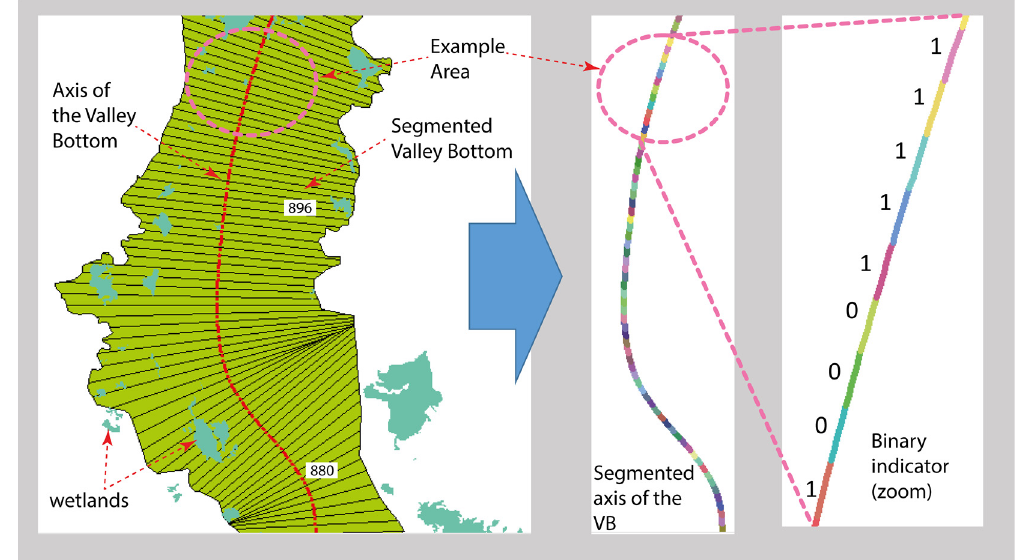
Figure 2. Creating the “river skeleton”: geomorphological units in the active channel (e.g., islands, bars, pools, riffle) or in the VB (e.g., levees, ridge and swales, paleo channels, wetlands) translate into a binary attribute of presence (1) or absence (0) in each discretization element (either of the floodplain or of the active channels envelope) along the VB axis. The example here refers to wetlands within the floodplain (warm green), represented by the cold green spots; notice that some are external to the VB because they lie at a higher elevation (hence not linked to the river). The right-hand figure represents the final binary information (here related just to the segment within the circle).